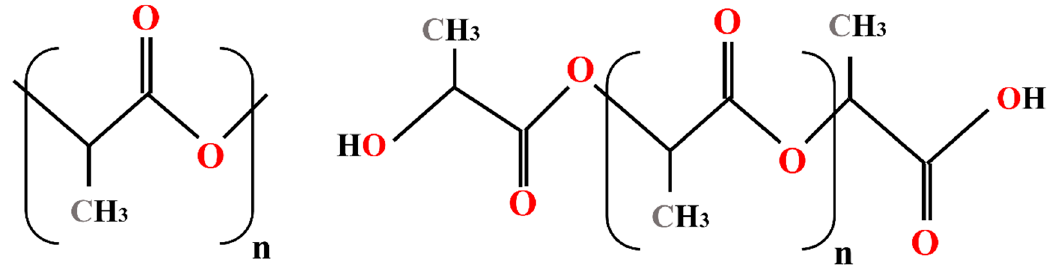
Figure 1. Chemical structure of PLA.